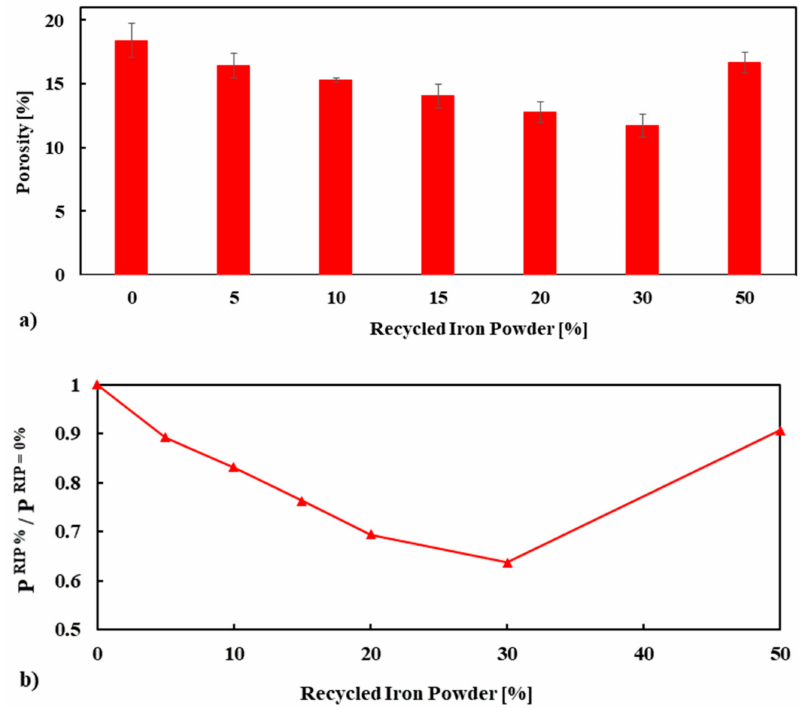
Figure 8. Apparent porosity (P) ( a ) and normalized P ( b ) of mortar specimens performed at 28 days.